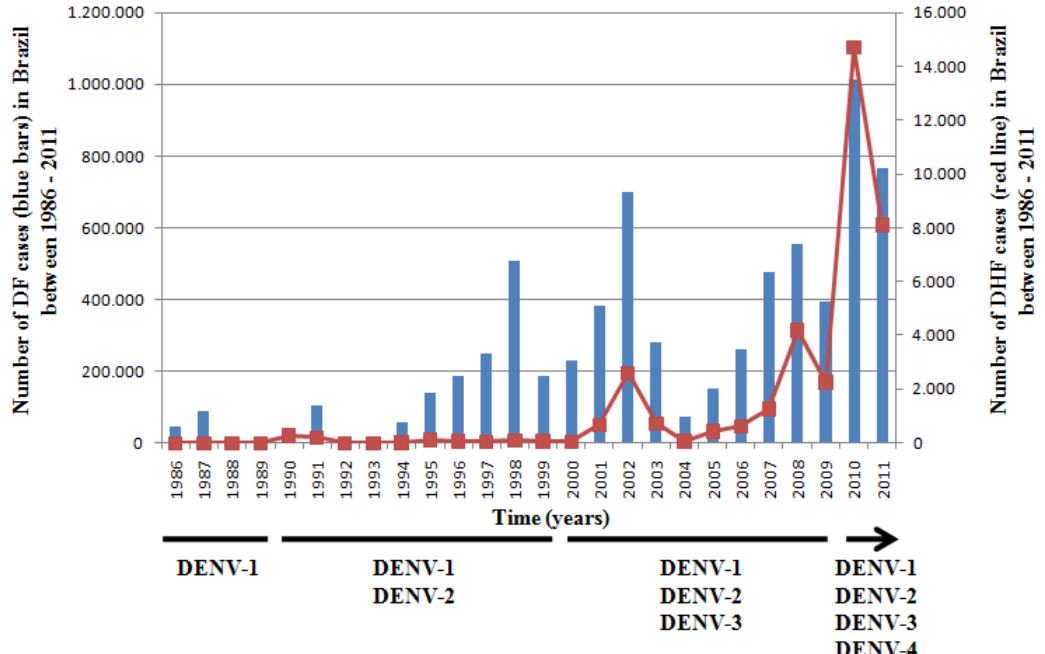
Figure 1. Incidence of dengue fever (blue bars) and dengue hemorrhagic fever (red line) in Brazil since its re-introduction in